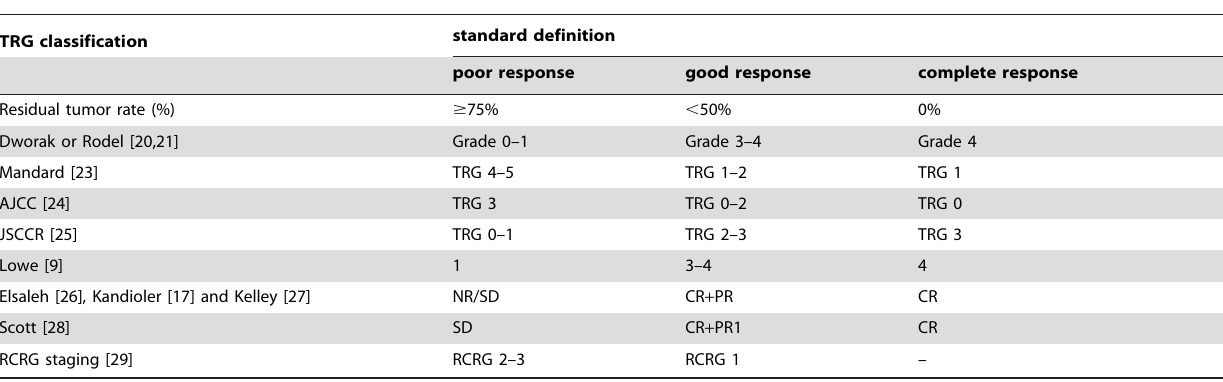
Table 1. TRG classification and standard definition.